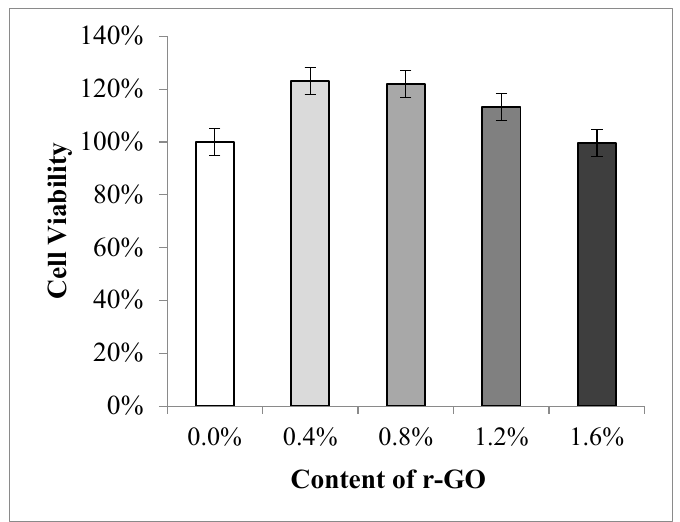
Figure 8. Cell Viability vs. Content of r-GO of Hydrogel Alginate/PVA/r-GO.